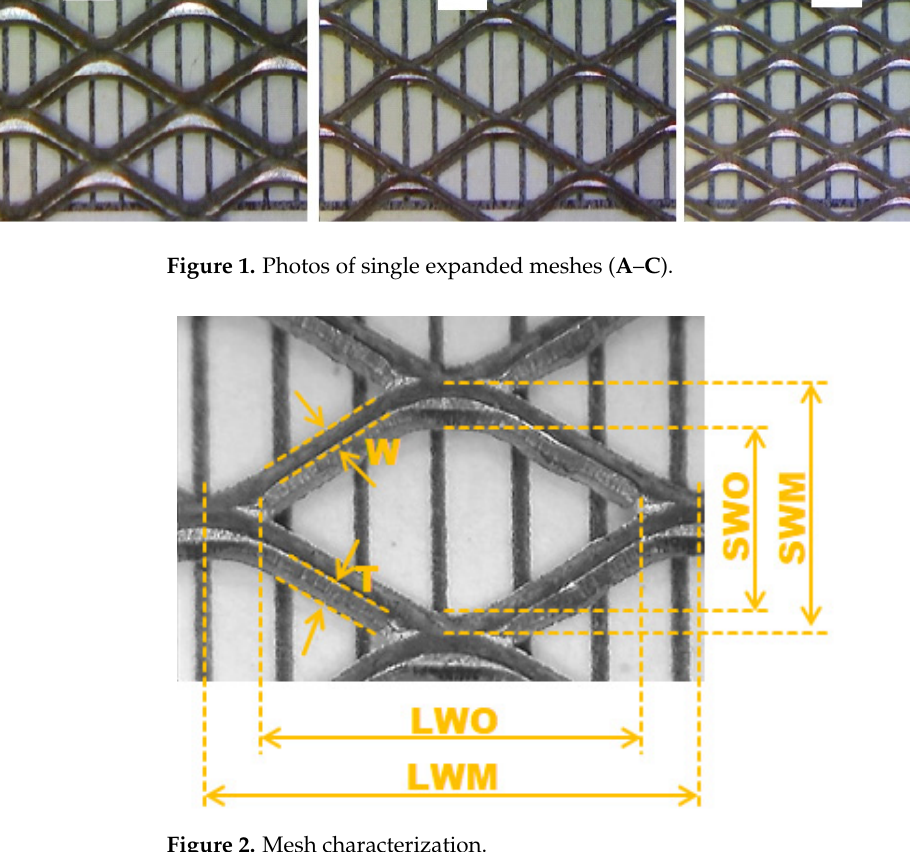
Figure 2. Mesh characterization. Table 1. Geometrical parameters of expanded meshes.